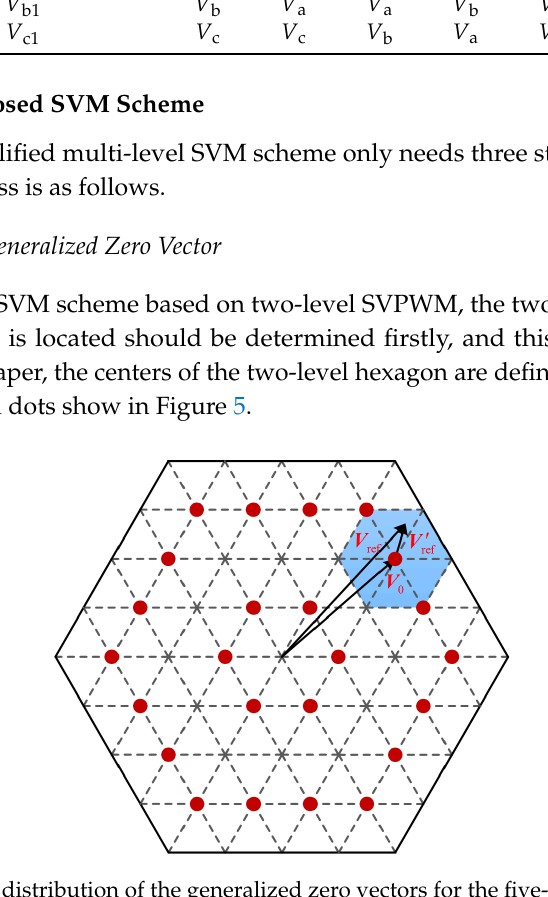
Figure 4. The symmetry of the voltage space vector distributions. Table 1. Equivalent coordinate components of the voltage space vectors in Sector I.